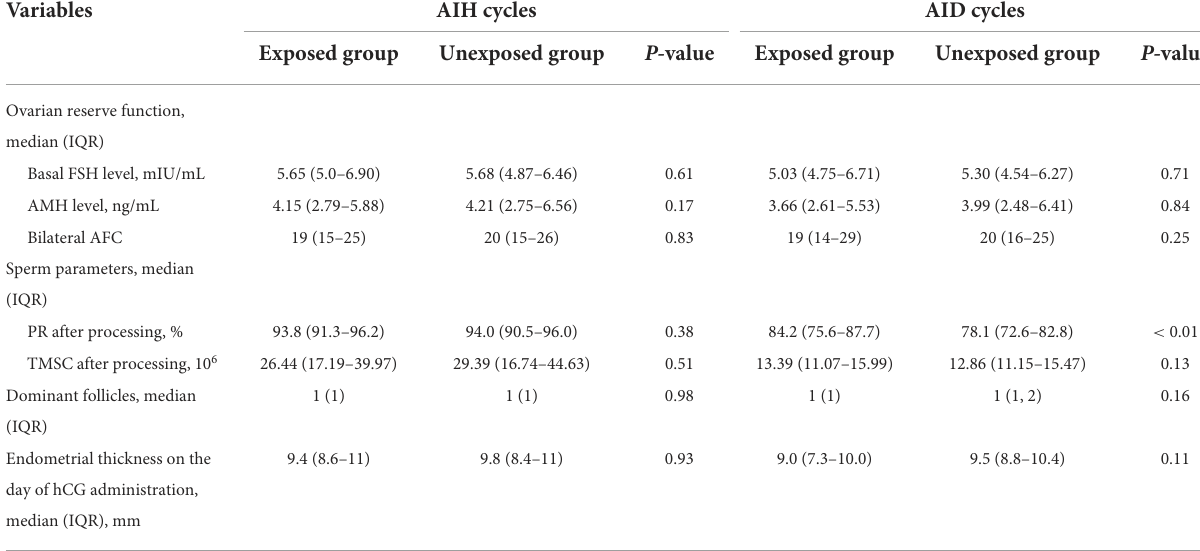
TABLE 3 Cycle variables per artificial insemination cycles with husband or donor semen stratified by vaccination exposed or not.